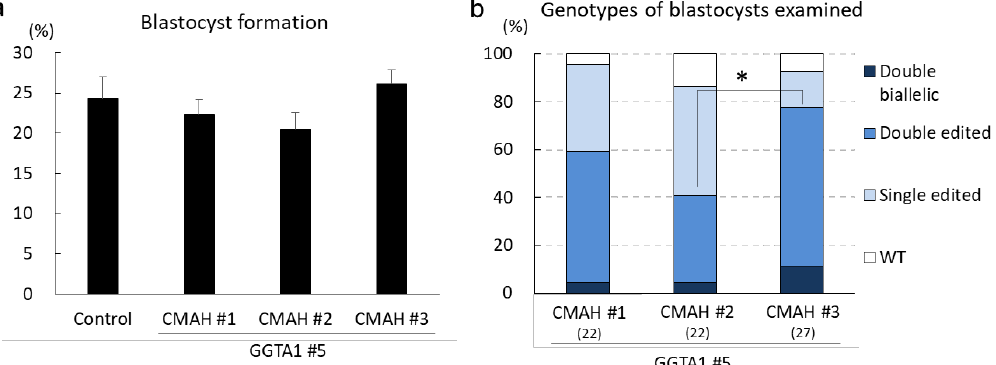
Figure 1. Optimization of gRNA combinations targeting GGTA1 and CMAH . ( a ) Blastocyst formation rates of electroporated zygotes. For each treatment group, five replicates with 263–268 oocytes per treatment were analyzed. Means ± SEM are shown. ( b ) Genotypes of blastocysts were determined using TIDE. Numbers within parentheses indicate the total numbers of examined blastocysts. Percentages of blastocysts carrying mutations in GGTA1 and CMAH were analyzed using chi-squared tests. * p < 0.05. WT, wild-type; Single edited, blastocysts carrying a mutation in GGTA1 or CMAH ; Double-edited, blastocysts carrying mutations in GGTA1 and CMAH ; Double biallelic, blastocysts carrying biallelic mutations in GGTA1 and CMAH .